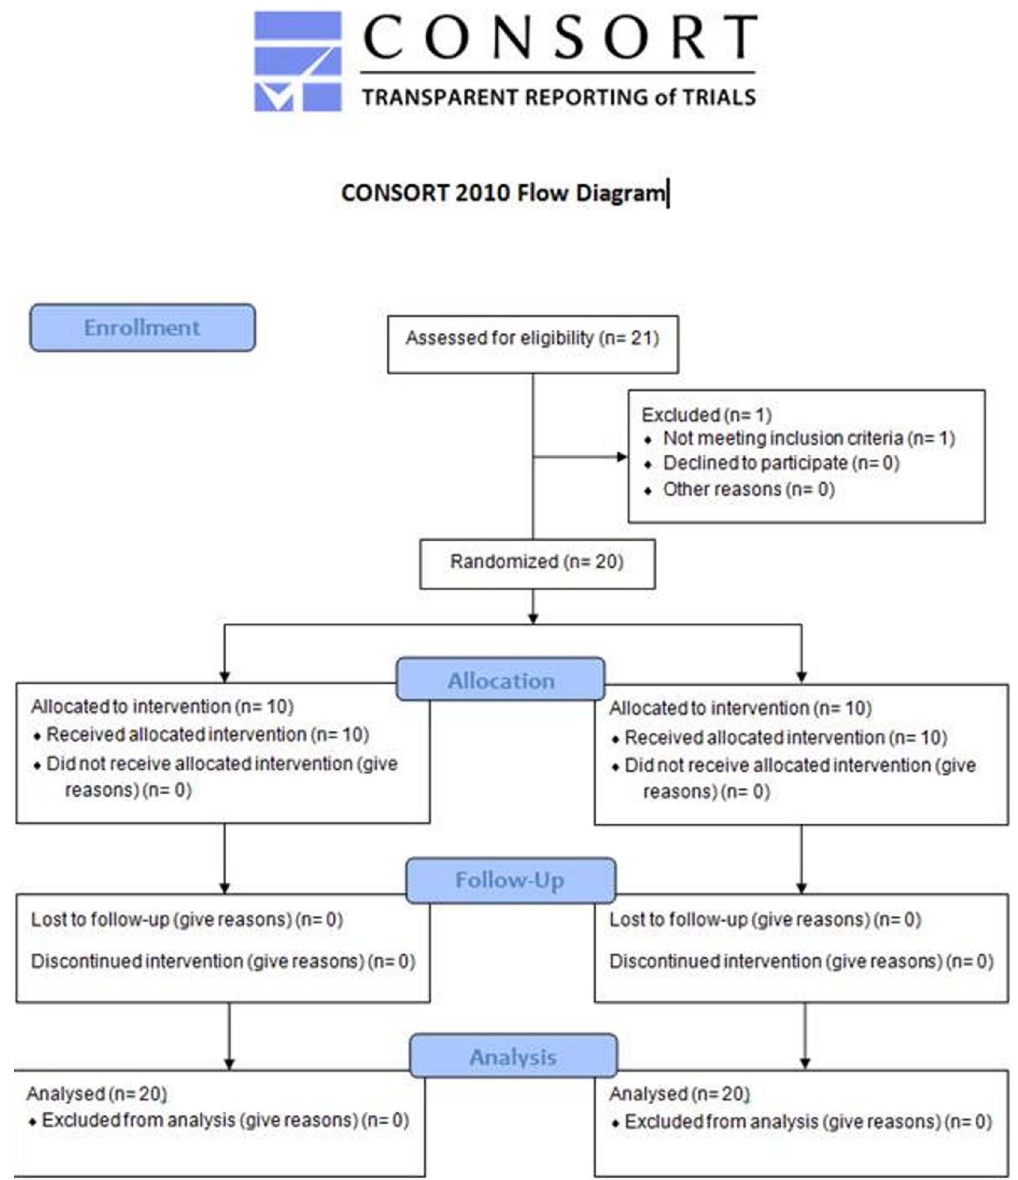
Figure 1. CONSORT flowchart of the study.